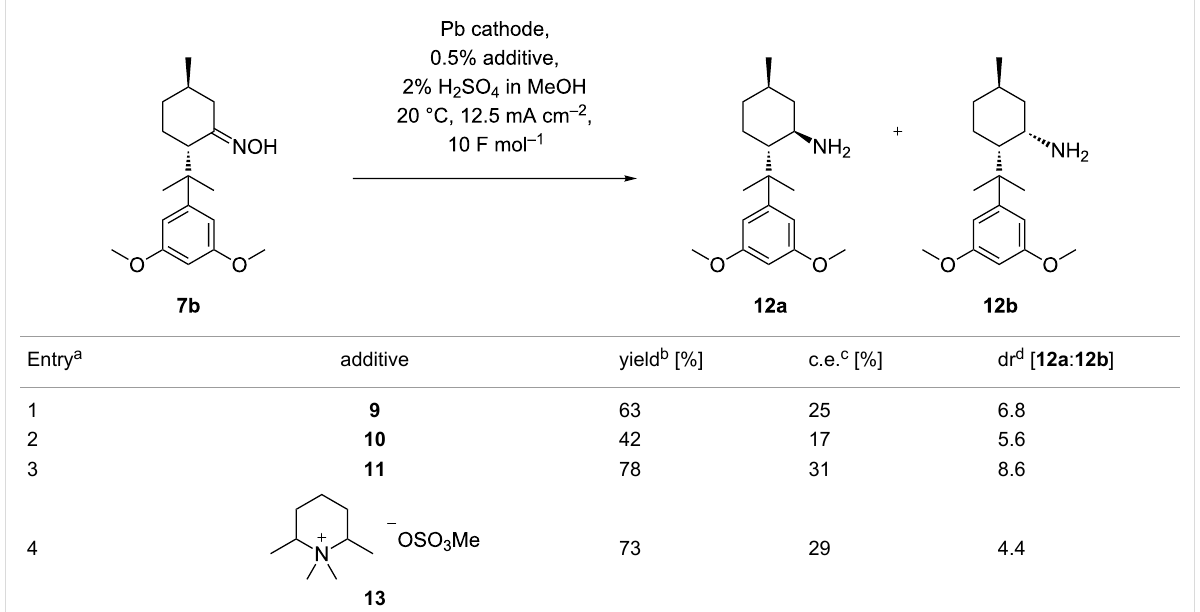
Entry a additive yield b [%] c.e. c [%] dr d [ 12a : 12b